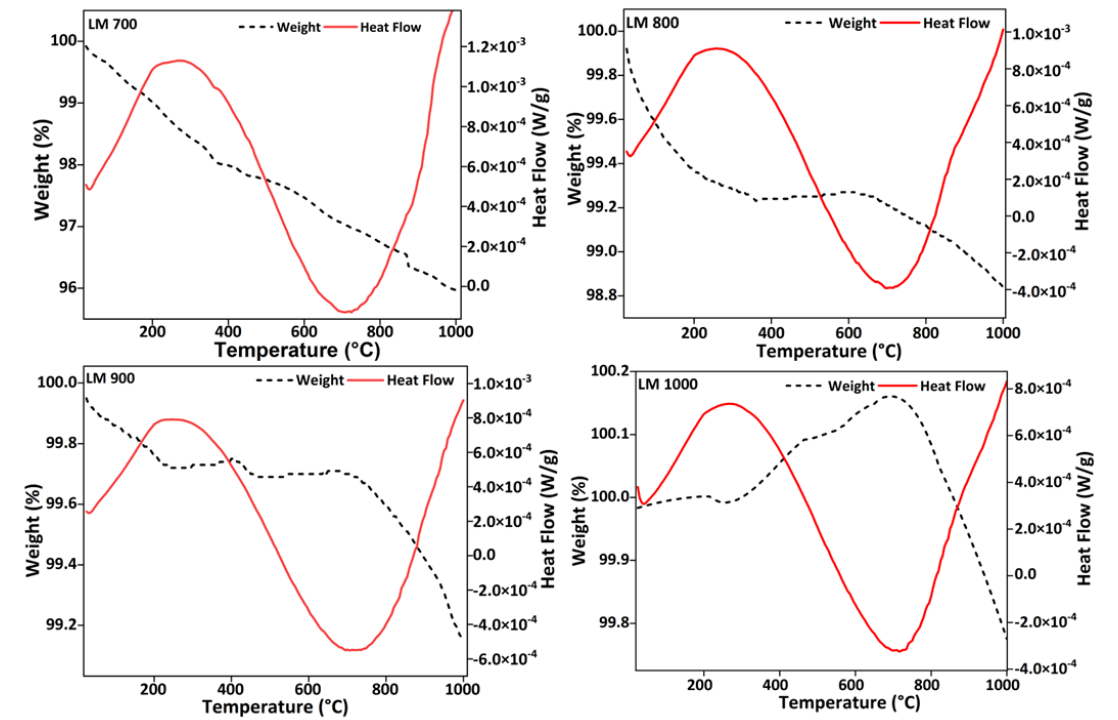
Figure 1. Thermogravimetric profiles of LM 700, LM 800, LM 900, and LM 1000. Powder XRD patterns for all the samples are shown in Figure 2. The patterns show peaks for lanthanum manganites, Pm-3m, and R3c structures [LaMnO 3 (ICSD-01-075-0440, 01-082-1152)], captured with peaks located at 2 θ values of 22.90 ◦ , 32. 61 ◦ , 40.22 ◦ , 46.82 ◦ , 58.18 ◦ , 68.39 ◦ , and 77.86 ◦ . The crystallinity of the compounds increased with calcination temperature and the XRD patterns are characteristic for La-based perovskites showing clear, sharp, and well-defined reflections. For LM 700, the unidentified impurity peaks at 21, 36, and 60 ◦ 2 θ were below and above the perovskite reflection line (110), while the major perovskite lines remained unaffected. The cubic LaMnO 3 symmetry, resulting from reducing conditions during synthesis, was visible in LM 700 and LM 800. At a thermal treatment of 800 ◦ C, the low intensity impurity peaks present in the LM 700 sample diminished. Peak profile sharpening, due to crystallite size increase and decrease in lattice strain was observed as the calcination temperature increased [38]. The unit cell of the ideal cubic phase observed in LM 700, indicated by comparison of the axes, transformed to a doublet in LM 1000. The unit cell dimensions listed in Table 1 correlate with the data published in a recent experimental and theoretical paper [39]. Prior to the Rietveld refinement analysis of LM 1000, we observed that the initial cell volume of LM 900 decreased by 0.6 Å 3 , which can be attributed to a minor error that could arise from using unrefined values to calculate cell